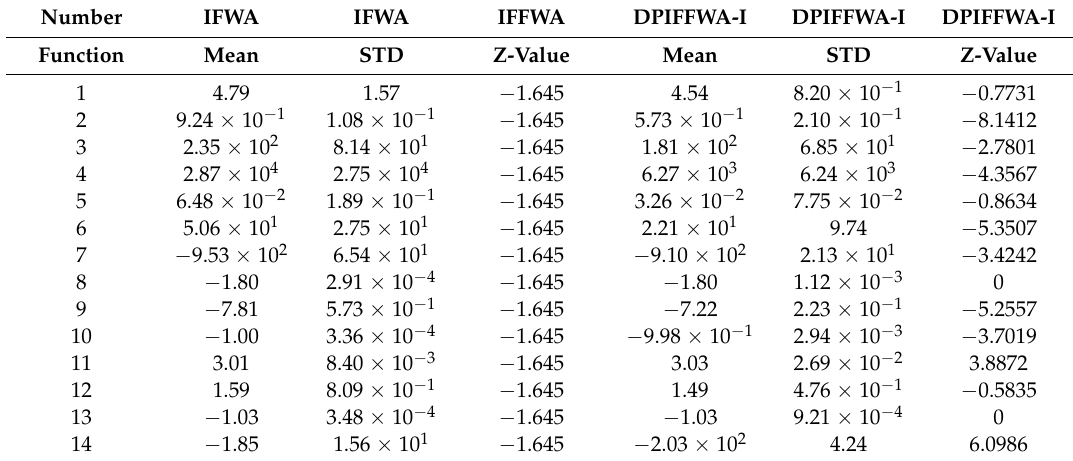
Table 11. Hypothesis test between IFWA and DPIFFWA-I with SI = 1.